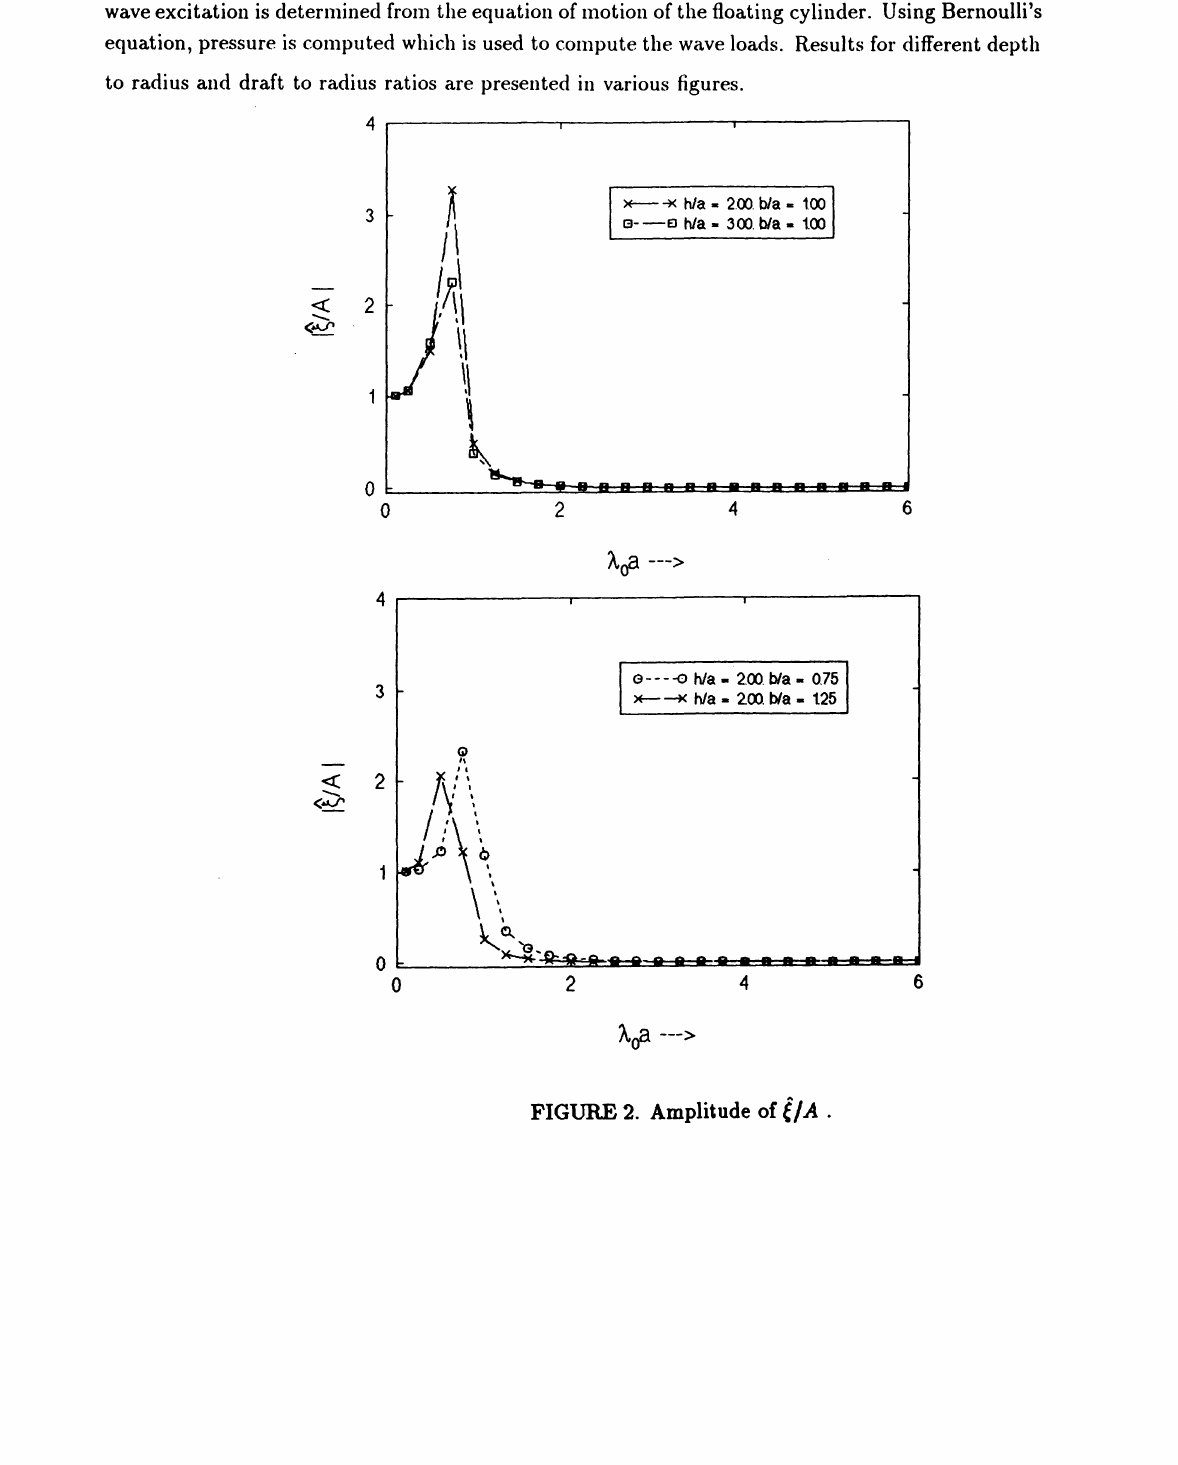
FIGURE 2. Amplitude of